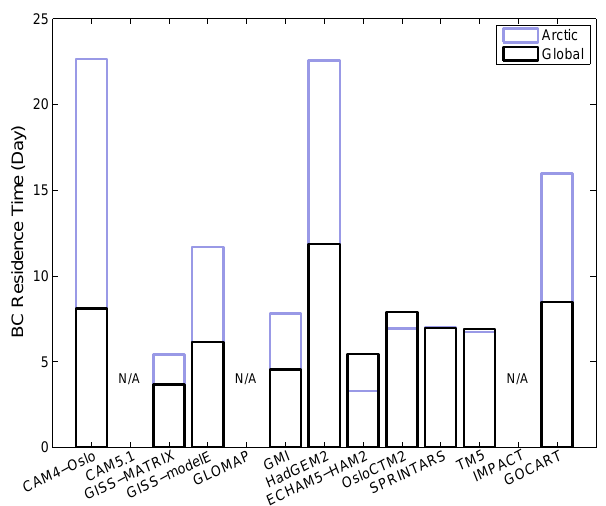
Fig. 10. Global and Arctic atmospheric residence times for black carbon in phase II models. (Three models are excluded in this analysis due to missing or incomplete data.)